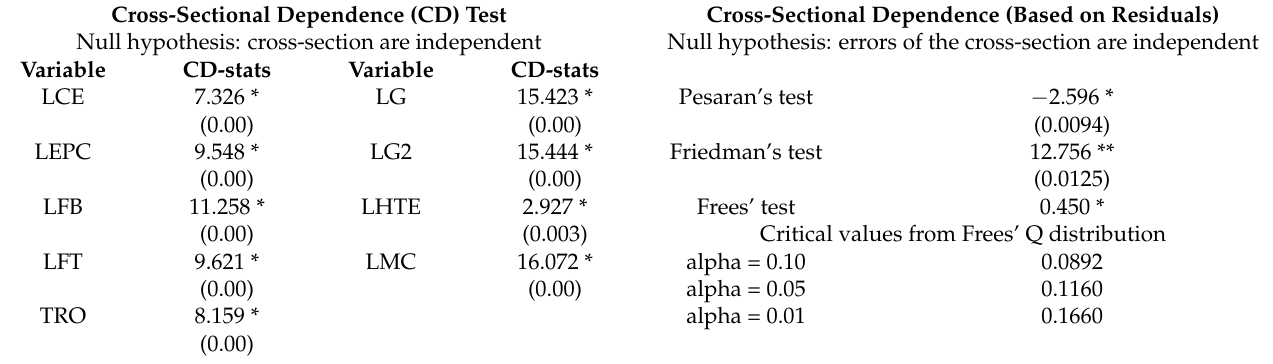
Table 3. Cross-sectional dependence analysis.